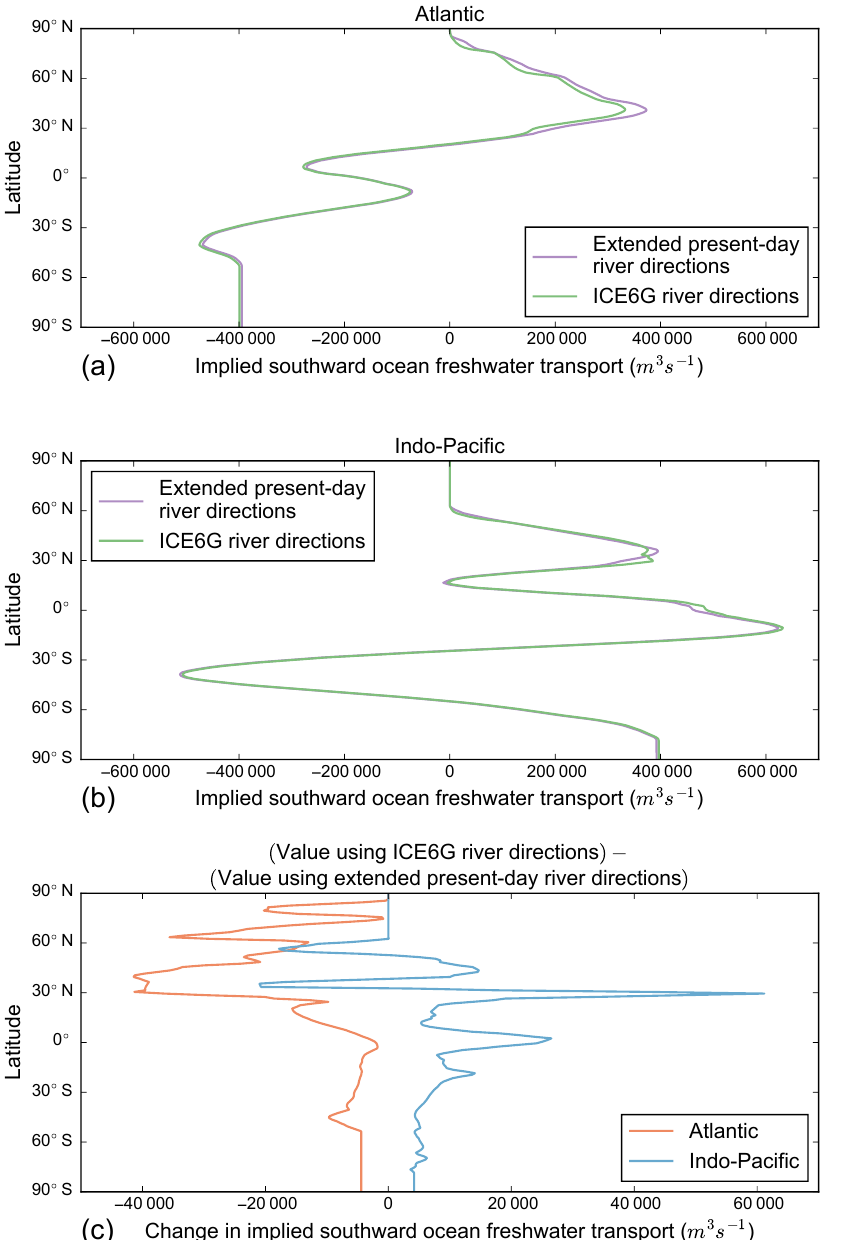
Figure 9. Comparison of the implied southward ocean freshwater transport between simulations run in the MPI-ESM model of the LGM using extended present-day river directions and using dynamic river directions for (a) the Atlantic Ocean and (b) the Indo-Pacific. Plot (c) gives the difference between the two simulations for both basins. The freshwater transport is defined such that a net addition of freshwater to the ocean (via precipitation and river discharge) is positive and a net removal of freshwater (via evaporation) is negative.